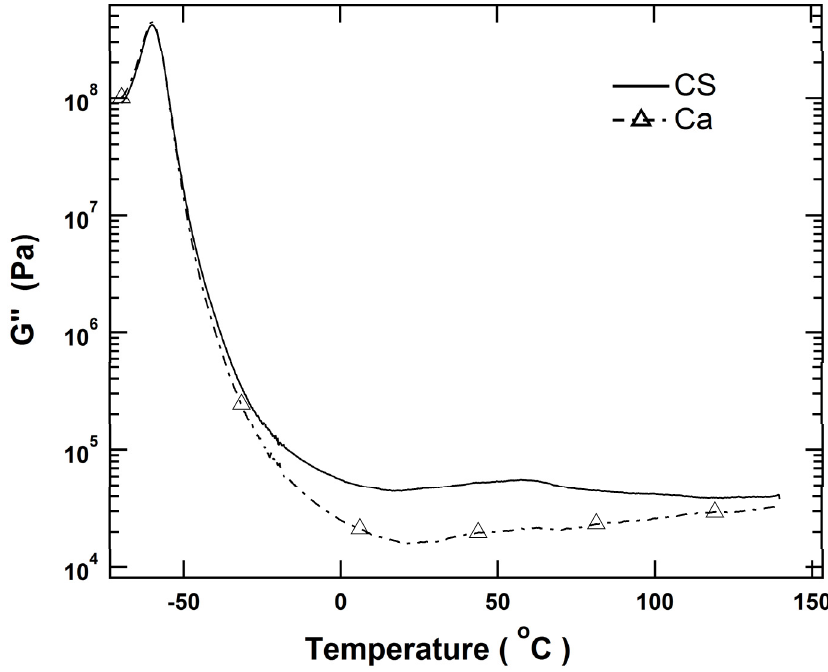
Figure 11. Loss moduli for stearic acid coated and uncoated CaCO 3 reinforced rubber at 50 phr.